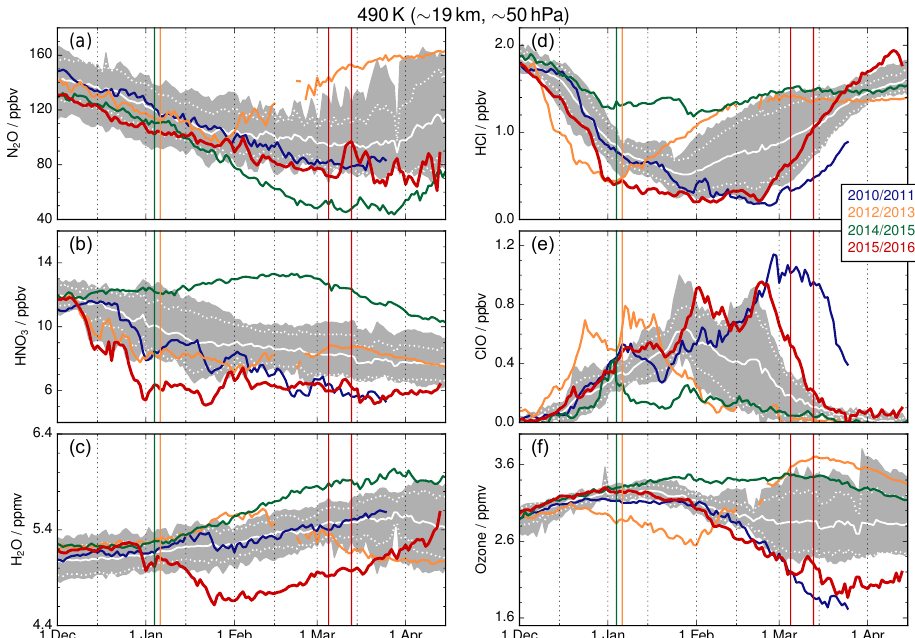
Figure 2. Time series of 490K MLS vortex-averaged N 2 O (a) , HNO 3 (b) , H 2 O (c) , HCl (d) , ClO (e) , and ozone (f) in the 2010/11 (blue), 2012/13 (orange), 2014/15 (green), and 2015/16 (red) Arctic winters compared with the mean (solid white), 1 standard deviation range (dotted white), and minimum/maximum range (grey shading) of other years in the Aura record (beginning with 2004/05). Vertical colored lines are as in Fig. 1. These vortex averages are calculated using the sum of the vortex regions identified by CAVE-ART with an 82 ◦ EqL cutoff to exclude un-climatological features due to very small vortex regions with anomalous characteristics in some years (the gap in the 2013 line shows a period when the lower-stratospheric vortex was undefined by this